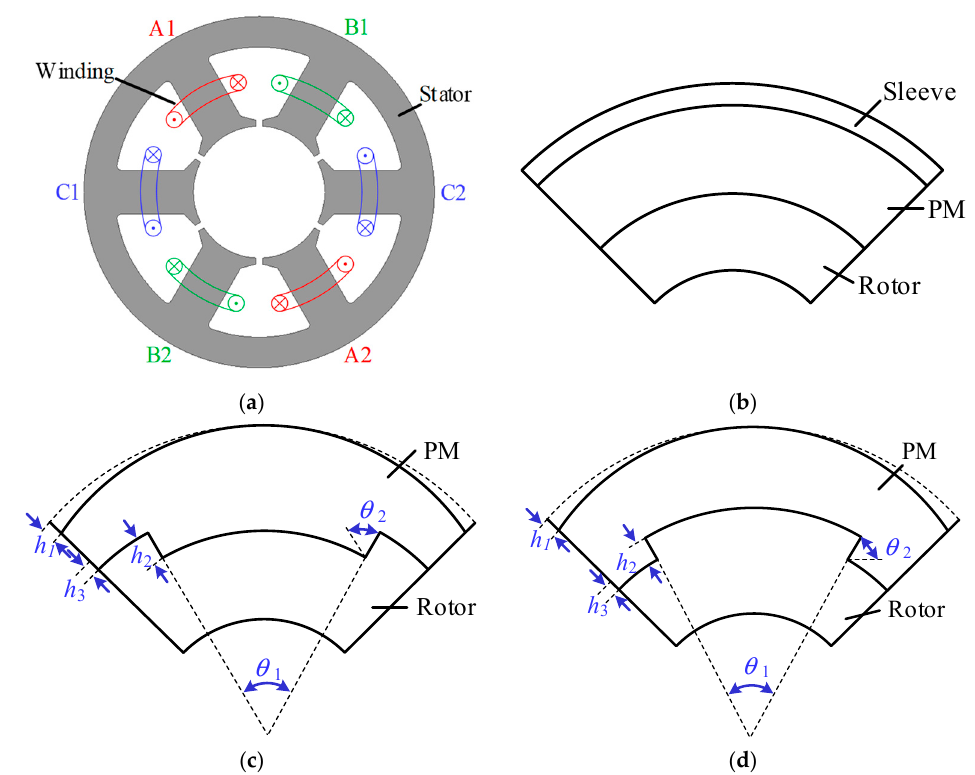
Figure 2. Cross-sectional view of 6-slot/4-pole motor with different rotors. ( a ) 6-slot stator and windings. ( b ) Conventional SPM rotor. ( c ) SIPM1 rotor. ( d ) SIPM2 rotor. Table 1. Main design parameters of 6-slot/4-pole motor.